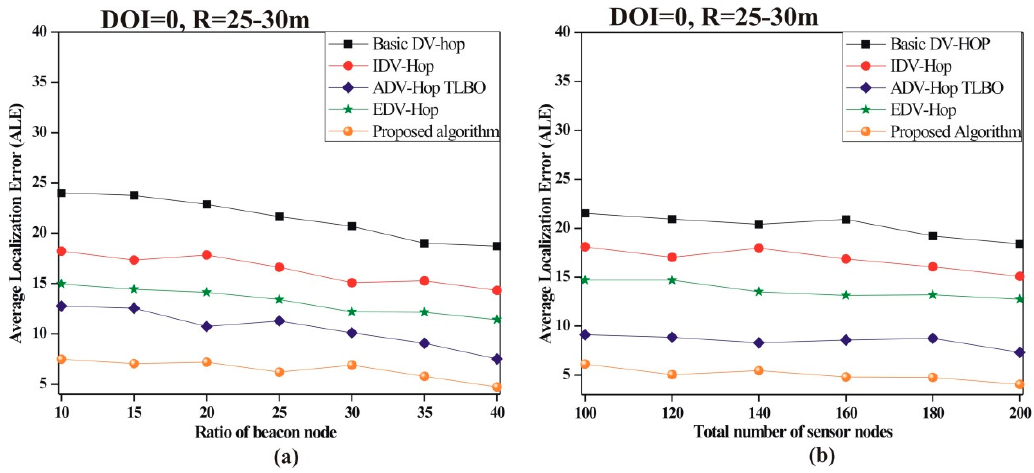
Figure 7. Impact on ALE by varying ( a ) ratio of beacon nodes; ( b ) node density.